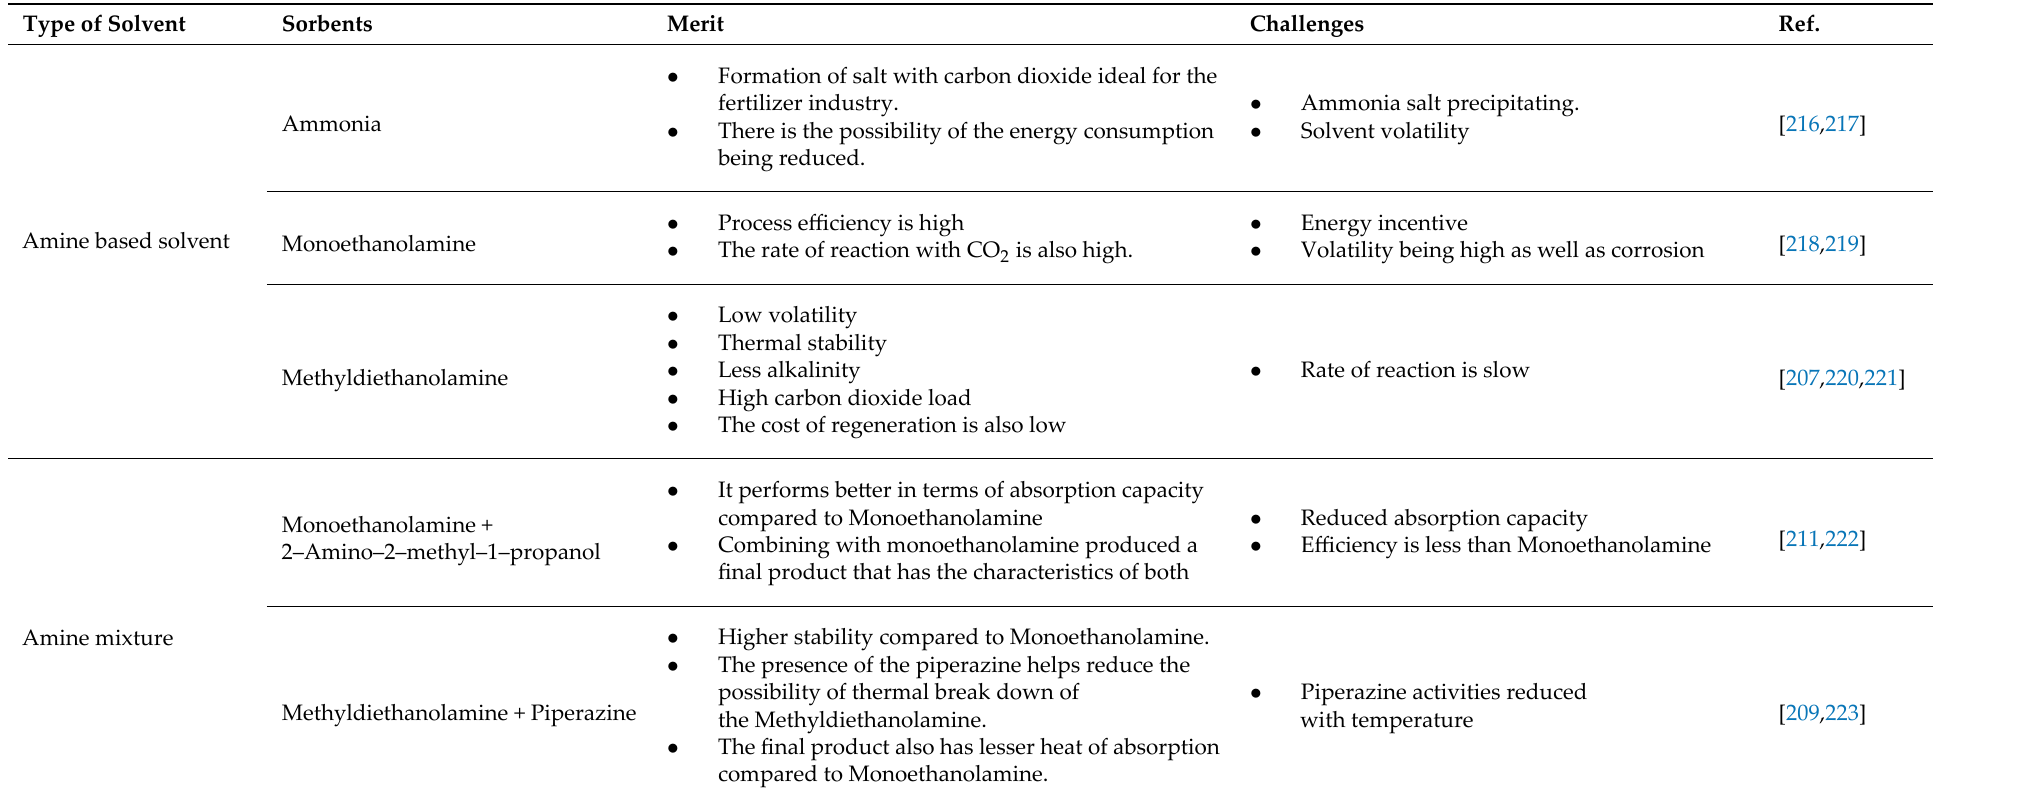
Table 5. Merits and demerits of liquid